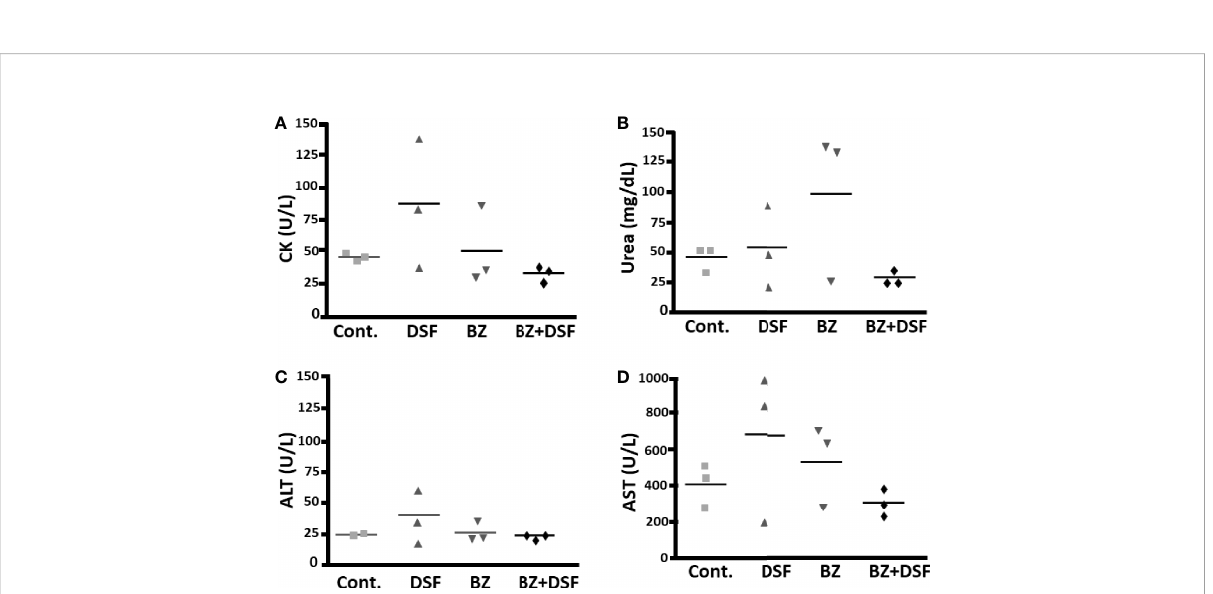
FIGURE 14 Systemic toxicity of mice treated with DSF and BZ, alone and in combination, by determining blood levels of creatine kinase (A) , urea (B) , alanine aminotransferase (C) and aspartate aminotransferase (D) ; after 20 mg/kg BZ or DSF and the 10 mg/kg/d BZ + 10 mg/kg/d DSF. Contrary to isolated drugs, the combination, employing lowered dosages, did not increase plasma